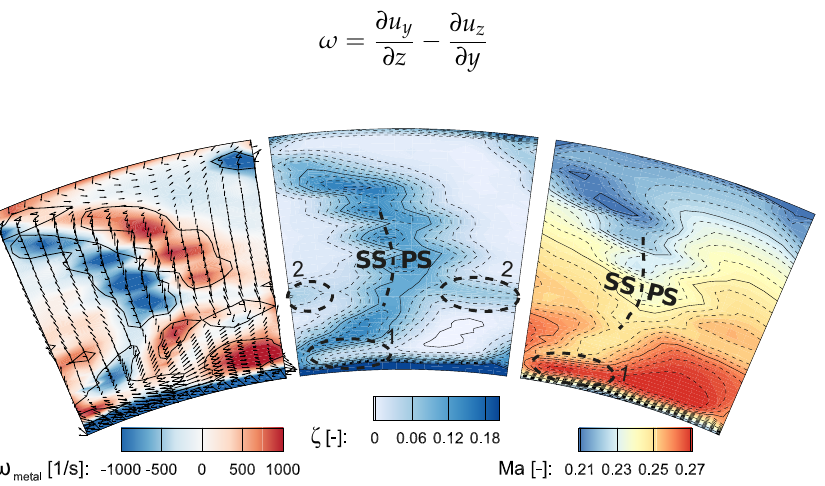
Figure 3. Five hole probe (5HP) results for axial (AX) inflow, mass flow ratio (MFR) 3 in NGV exit plane ME02.